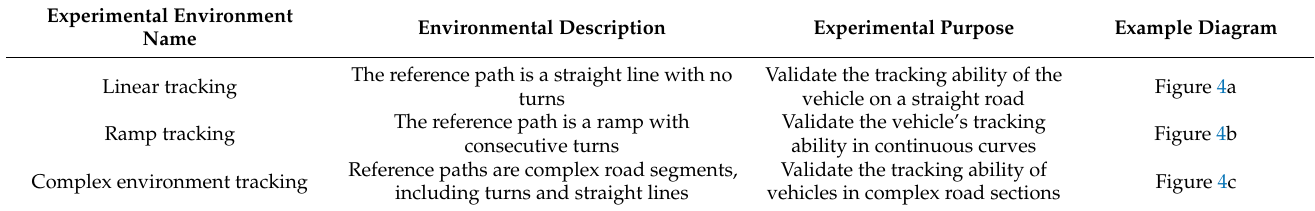
Table 4. Experimental